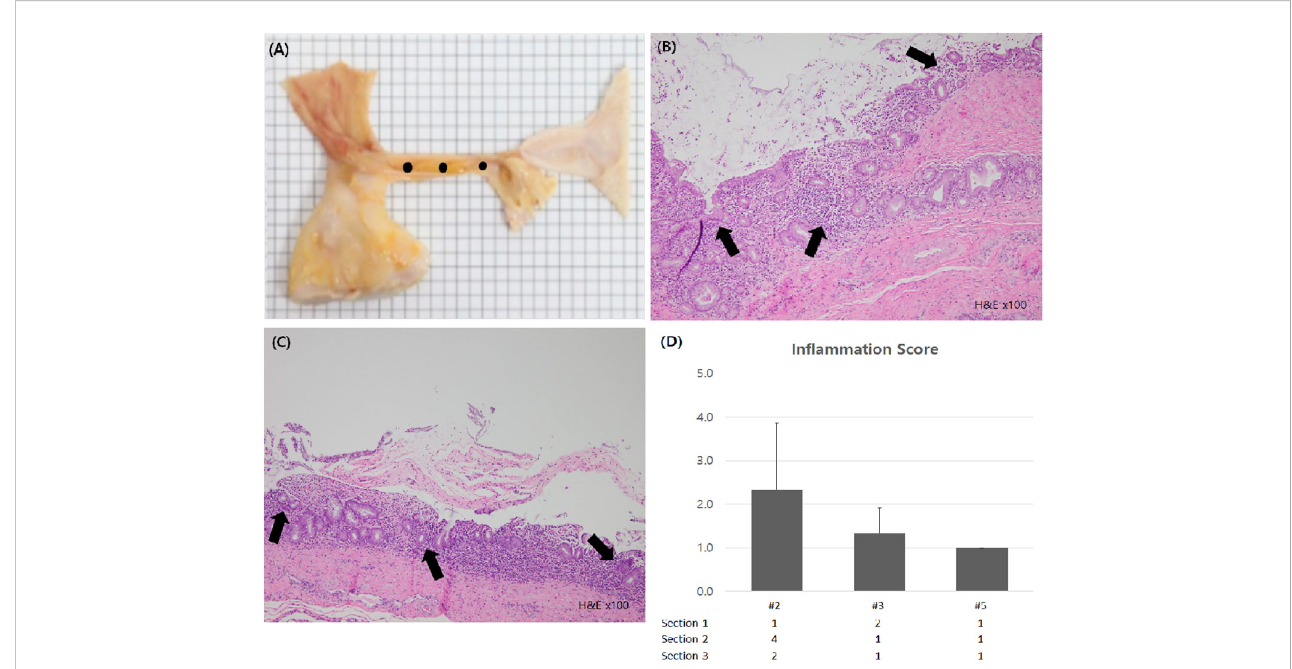
FIGURE 5 Histologic examination of bile duct. (A) Gross inspection of extracted bile duct was conducted. For microscopic examination, fi xed sample was sectioned at 3 levels (black dots). (B, C) In fl ammatory cell in fi ltration sites were seen in the bile duct mucosa of subject #2 and #3 (black arrow, H&E X100) (D) In fl ammation scores of each subject were calculated and